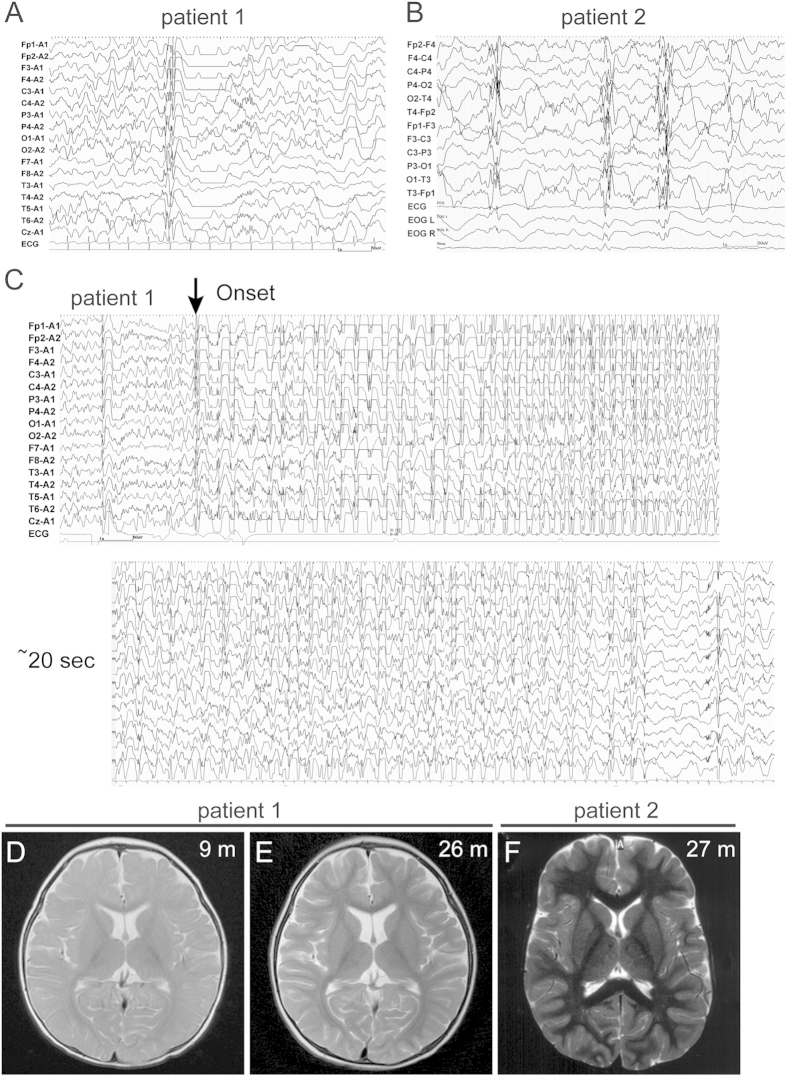
EEG and brain MRI features of patients with KCNB1 mutations.(A,B) Interictal EEG tracing of patient 1 at 18 months of age, and patient 2 at 2 years and 11 months. (A) Diffuse irregular polyspikes and waves with intermittent focal spikes during the sleep state in patient 1. (B) Diffuse irregular slow spikes and waves, and polyspikes and waves during the sleep state in patient 2. (C) Ictal EEG tracing of patient 1 at 23 months showed runs of diffuse slow spike and wave discharges beginning at 2 Hz and accelerating to 3–3.5 Hz irregular spikes and waves, followed by a mixture of irregular spikes intermingled with arrhythmic slow activities that accompanied generalized clonic seizures. Seizures lasted approximately 50 seconds. (D–E) T2-weighted axial brain MRI of patient 1. (D) MRI at 9 months showed normal findings. (E) MRI at 2 years 2 months showed slight cortical atrophy especially in the frontal lobes. (F) T2-weighted axial brain MRI of patient 2 showed normal findings. m, months; y, years